Question: Which visualization type does this figure use?
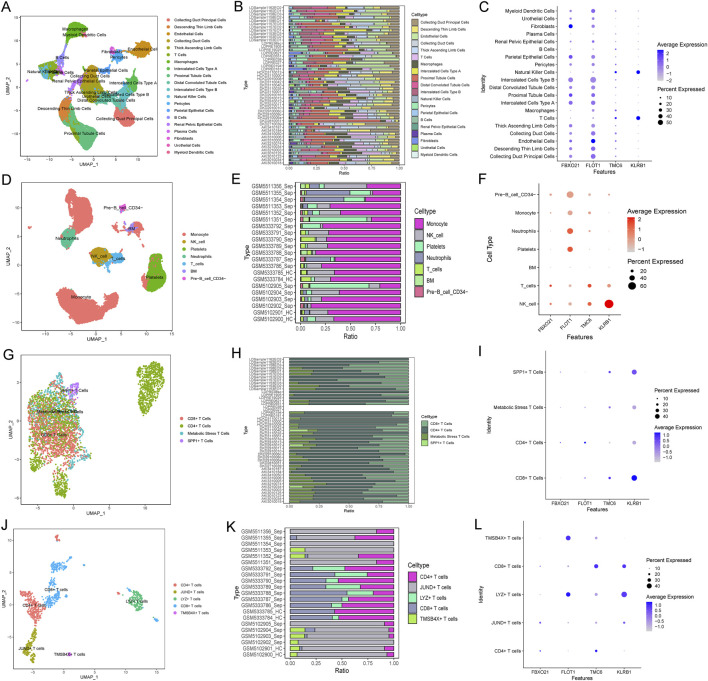
Answer: scatter